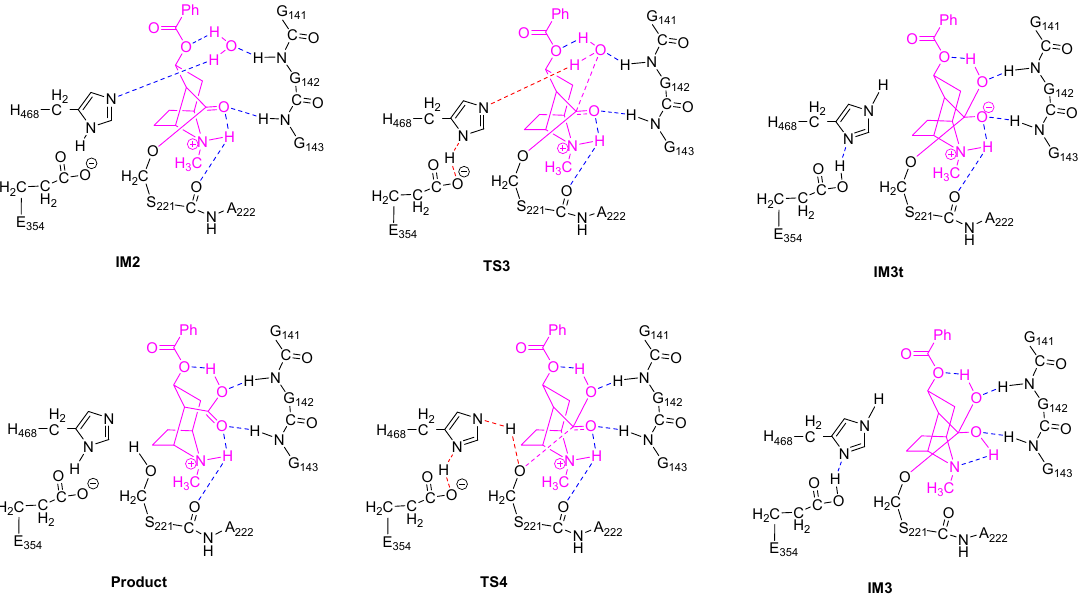
Figure 3. Transition states and intermediates in the deacylation stage of hCES1.